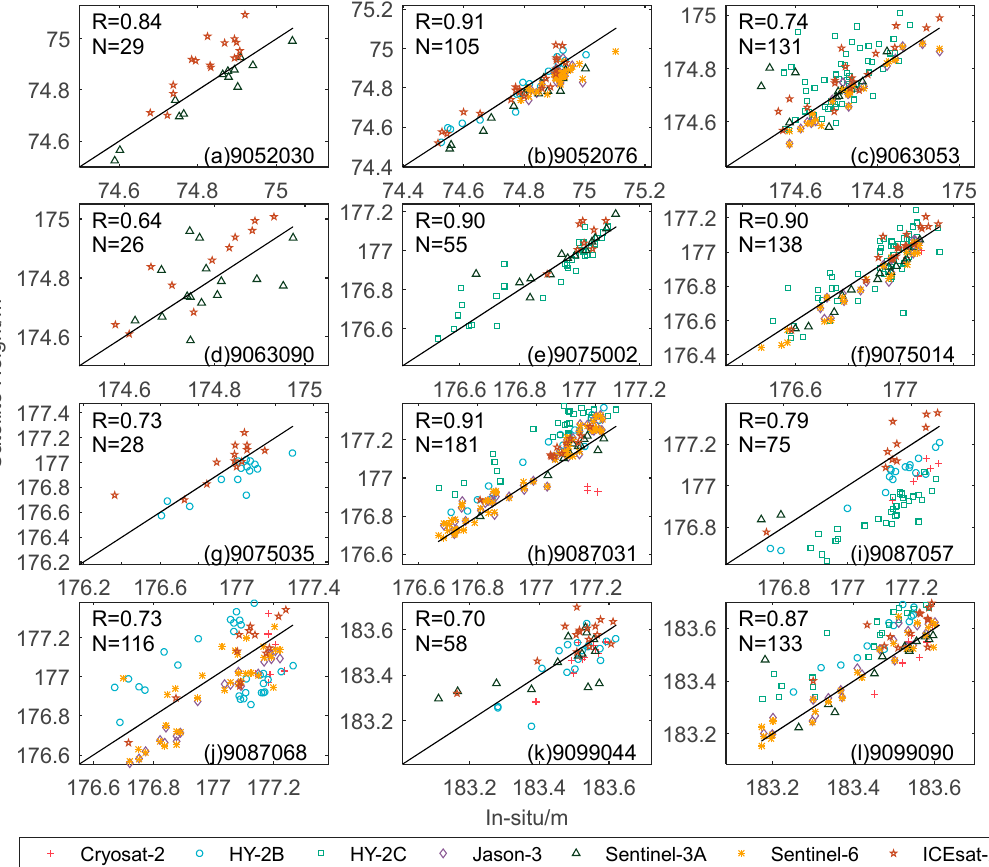
Figure 6. Comparison of the correlation between satellite measured water levels and in-situ data around 12 stations in the Great Lakes, where R is the total correlation coefficient, and N is the total number of measured water